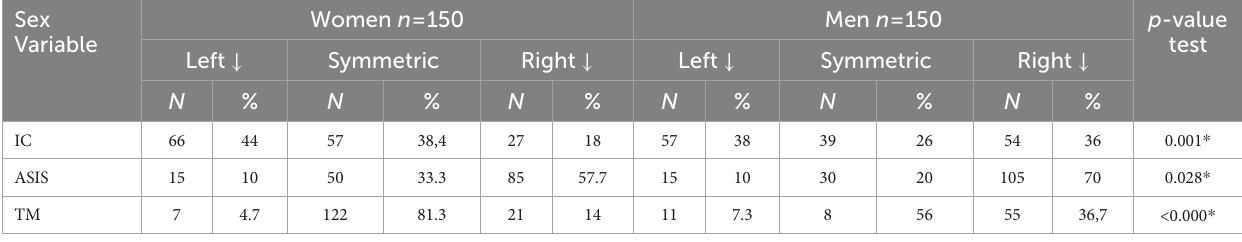
TABLE 3 Direction of asymmetry of IC, ASIS, and TM tops position by gender.